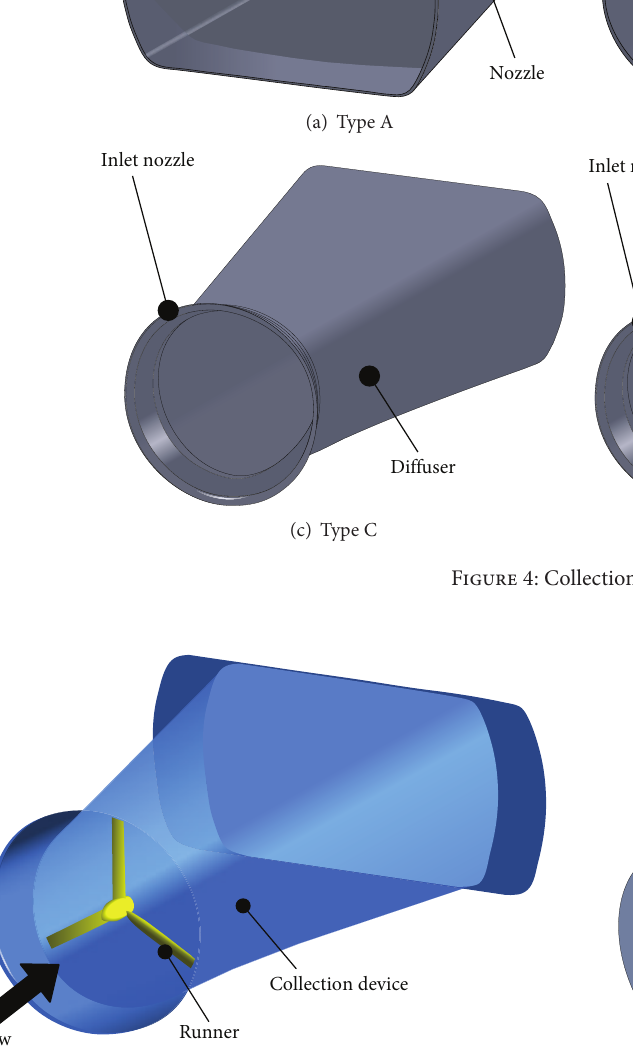
Figure 5: Computational model.